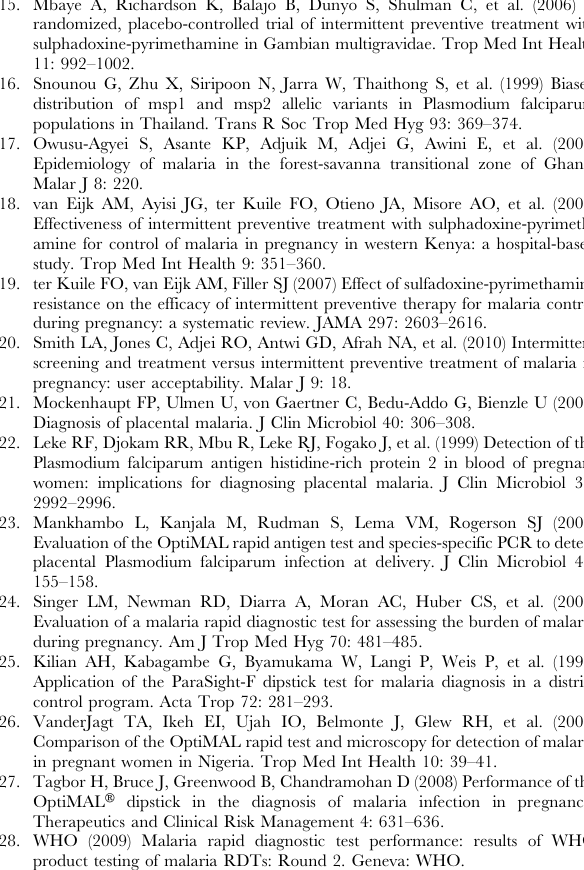
Table S3 Comparison of number of women who experienced adverse events within seven days of drug administration.